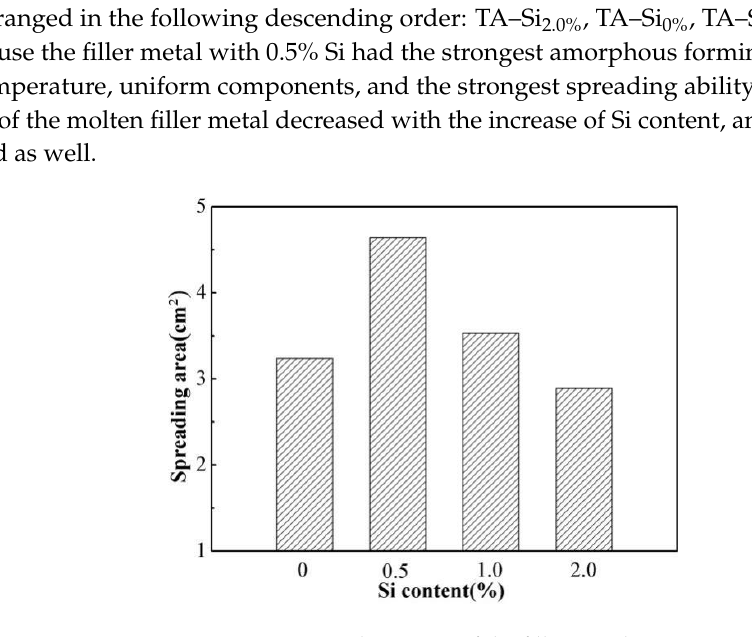
Figure 5. Spreading areas of the filler metals.